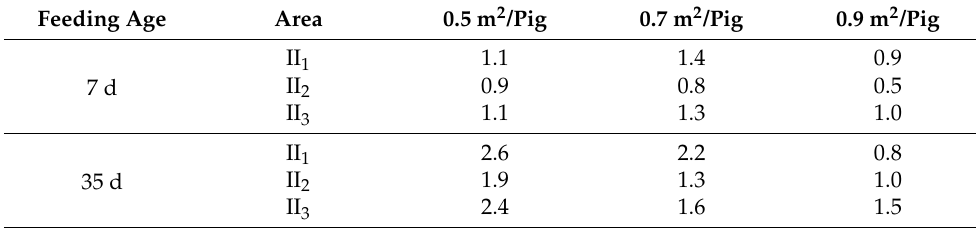
Figure 5. Manure coverage of the solid floor. Table 4. Cleanliness score of the pig pen solid floor.